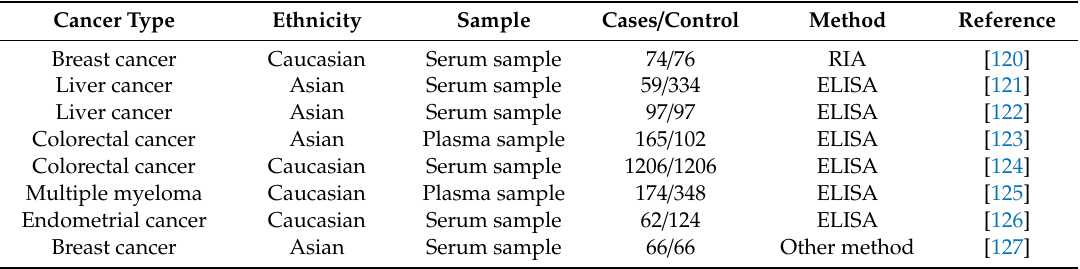
Table 2. Studies showing circulating HMW adiponectin and its association with cancer risk. RIA: radioimmunoassay; ELISA: enzyme linked immunosorbent